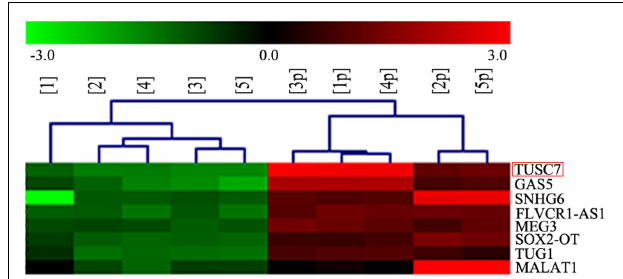
FIGURE 1 | LncRNA microarray analysis of total RNA isolated from five glioma tissues and corresponding adjacent normal brain tissues. 1–5: glioma, 1p–5p: